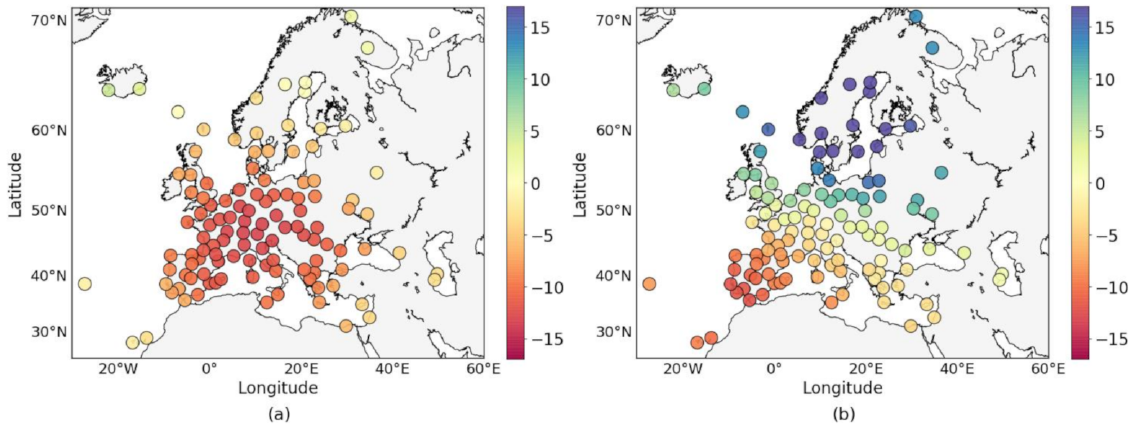
Figure 4. First ( a ) and second ( b ) spatial pattern of the weekly SP